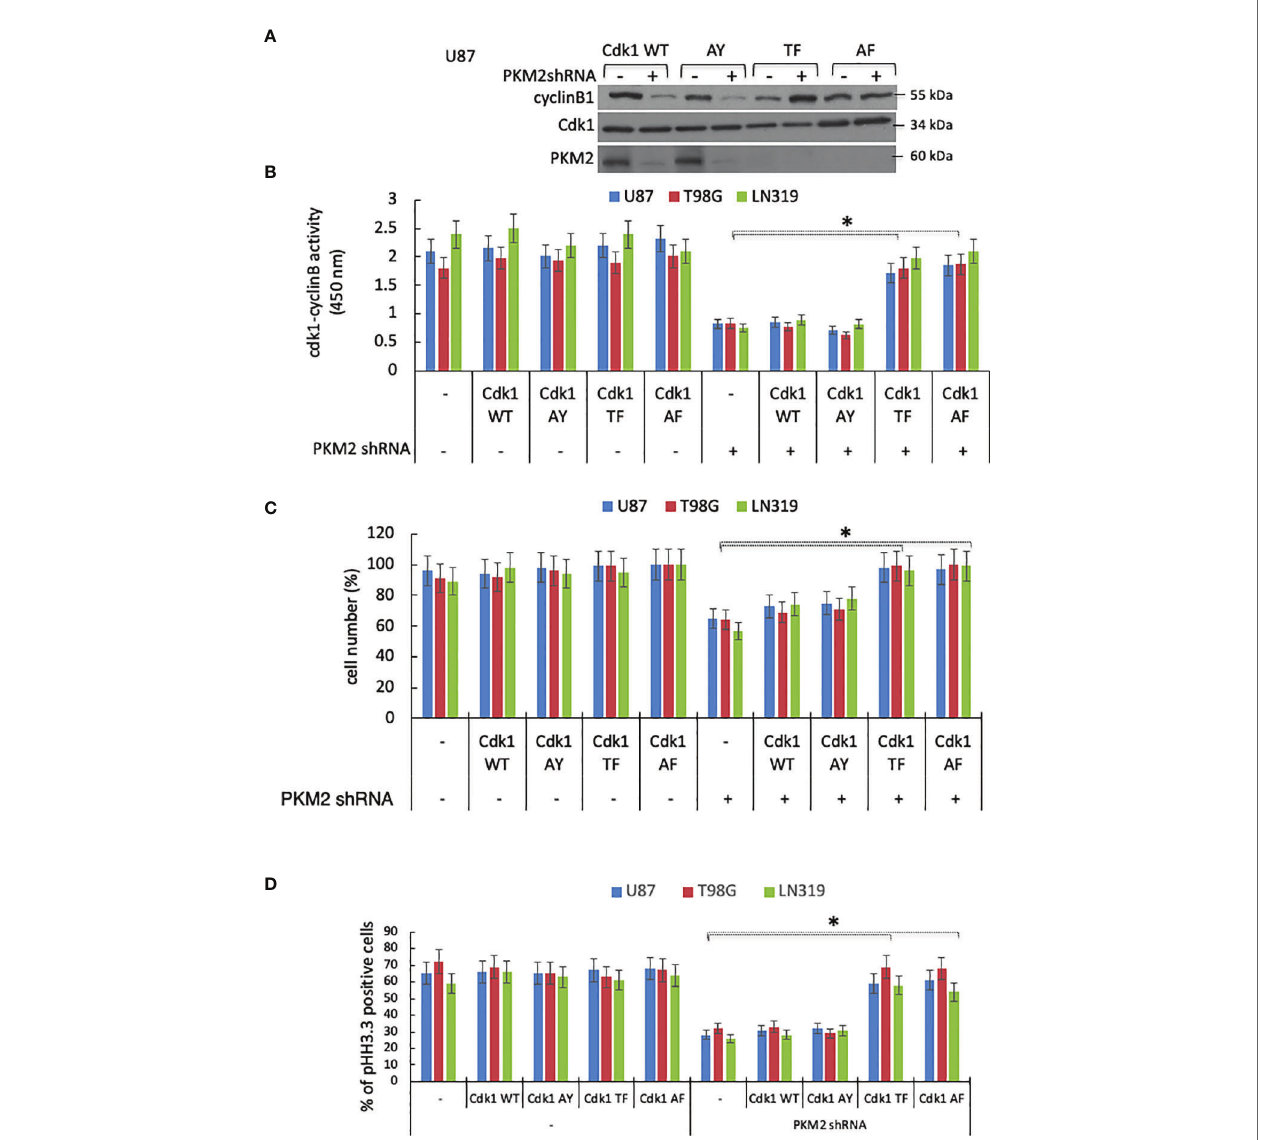
FIGURE 4 | A Y15 Cdk1/PKM2 interaction facilitates Cdk1-cyclin B activation and cell cycle progression. (A) Levels of cyclin B Cdk1, and PKM2 in nuclear GFP immunoprecipitates from control or PKM2 shRNA-expressing U87 cells expressing GFP-tagged WT, AY, TF or AF forms of Cdk1 measured 10 hrs after release of cells from serum deprivation-induced cell arrest. (B) Cdk1-cyclin B activity in lysates from U87, T98G and LN319 cells expressing GFP-tagged WT, AY, TF or AF forms of Cdk1 measured 10 hrs after release of cells from serum deprivation-induced cell arrest as determined by an in vitro kinase activity assay. (C) Normalized cell number in control and PKM2 shRNA-expressing U87, T98G and LN319 cells expressing GFP-tagged WT, AY, AF, or TF forms of Cdk1 48 hrs after plating. (D) cells from panel-b were assessed for the percentage of mitotic pHH3.3+ cells by FACS. *p <.05,